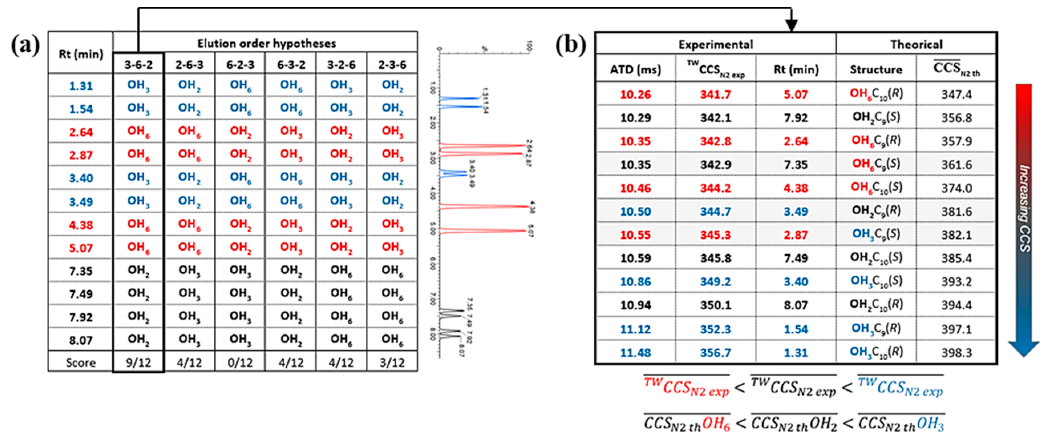
Figure 3. ( a ) Assignment hypotheses of the β -CD hydroxyl groups (OH 2 , OH 3 , and OH 6 ) involved in the epoxide opening reaction according to LC / MS elution and MS / MS groups. ( b ) Comparison of the increasing ranking of CCS N2 th with those of TW CCS N2 exp in the case of assignment hypothesis (3-6-2). The highlighted grey lines correspond to the three negative matches between expected OH assignment hypothesis and CCS prediction, leading to a score of 9/12.